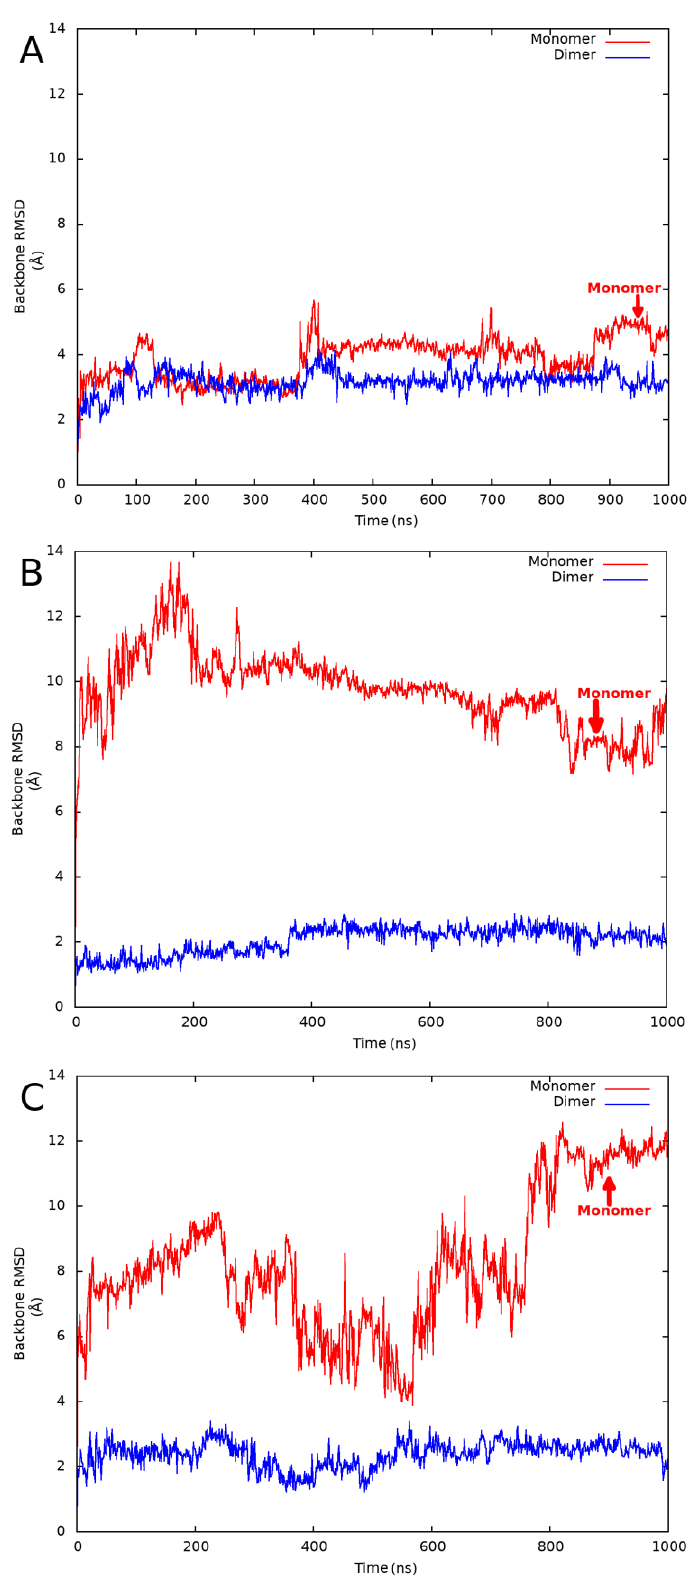
Figure 1. Example backbone RMSD plots obtained from the monomeric (red curve) and dimeric (blue curve) MD simulation of the ( A ) 4low globular protein; ( B ) 4cn0 expected MSF protein; and ( C ) 4me7 MSF protein.